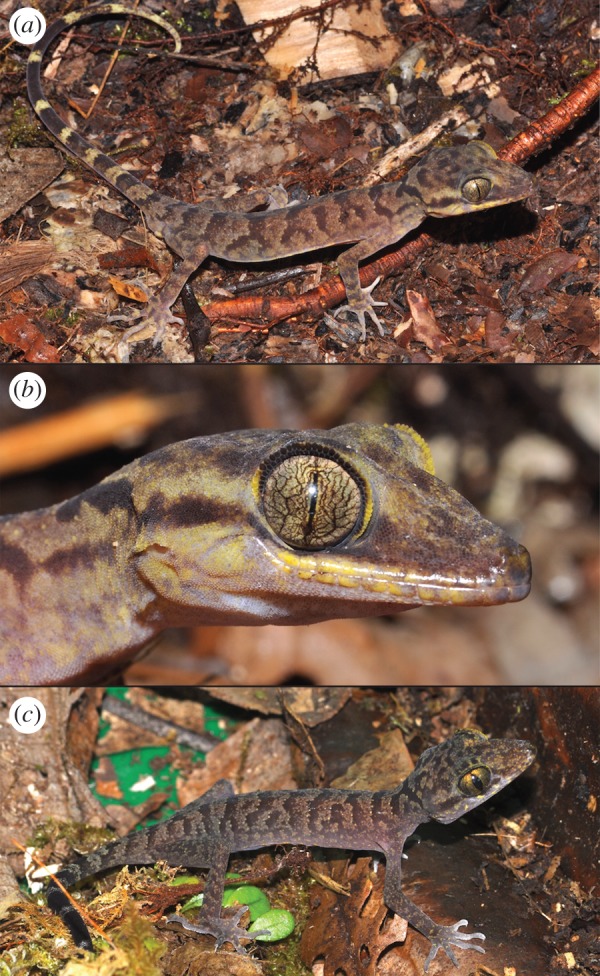
Cyrtodactylus tanim n. sp. in life. Paratypes SJR14637 (a,b) and NMV75961 (c) displaying juvenile coloration. Photographs: Paul M. Oliver.